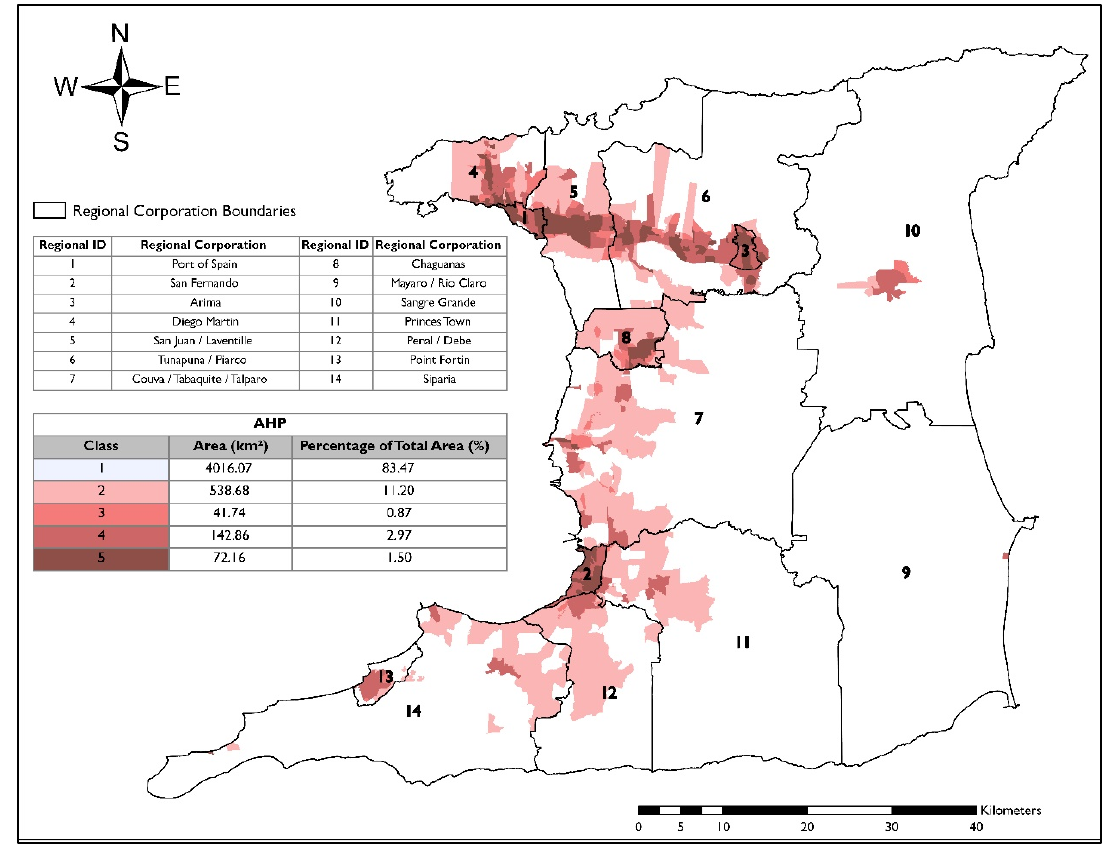
Figure 10. Vulnerability Indexes created for AHP.